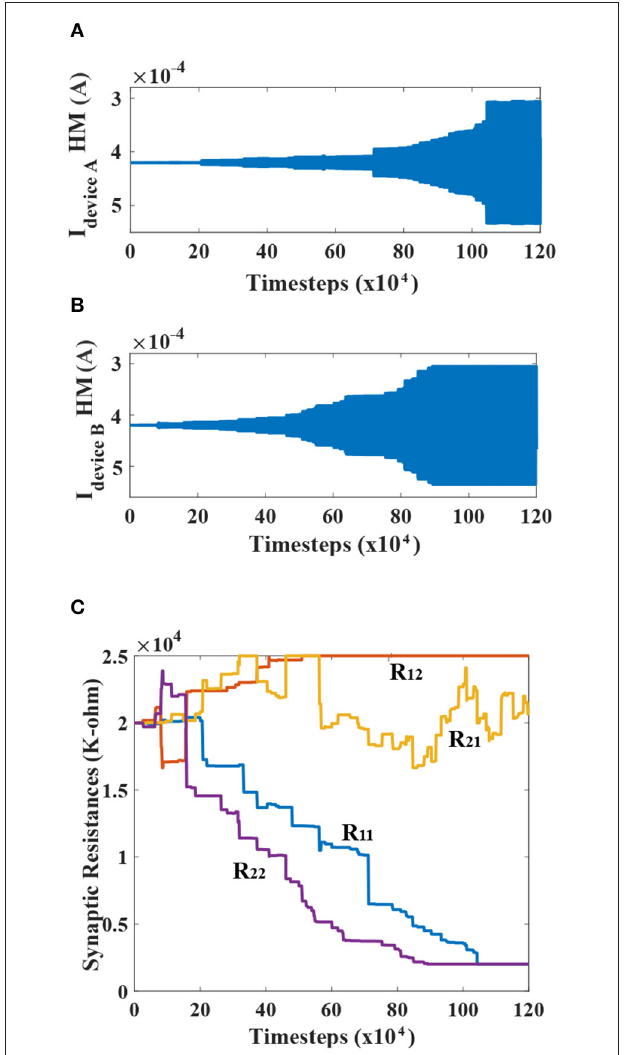
FIGURE 6 | (A,B) The temporal evolution profiles of the net currents (DC+AC) flowing through the heavy metal for devices A and B are shown. The increasing AC amplitudes about the mean DC value can be seen. The relatively flattened envelopes post-learning suggest that the post-neuron devices are dominantly locked to one of the frequencies. (C) Temporal evolution of the cross-bar resistances during the learning process is shown.